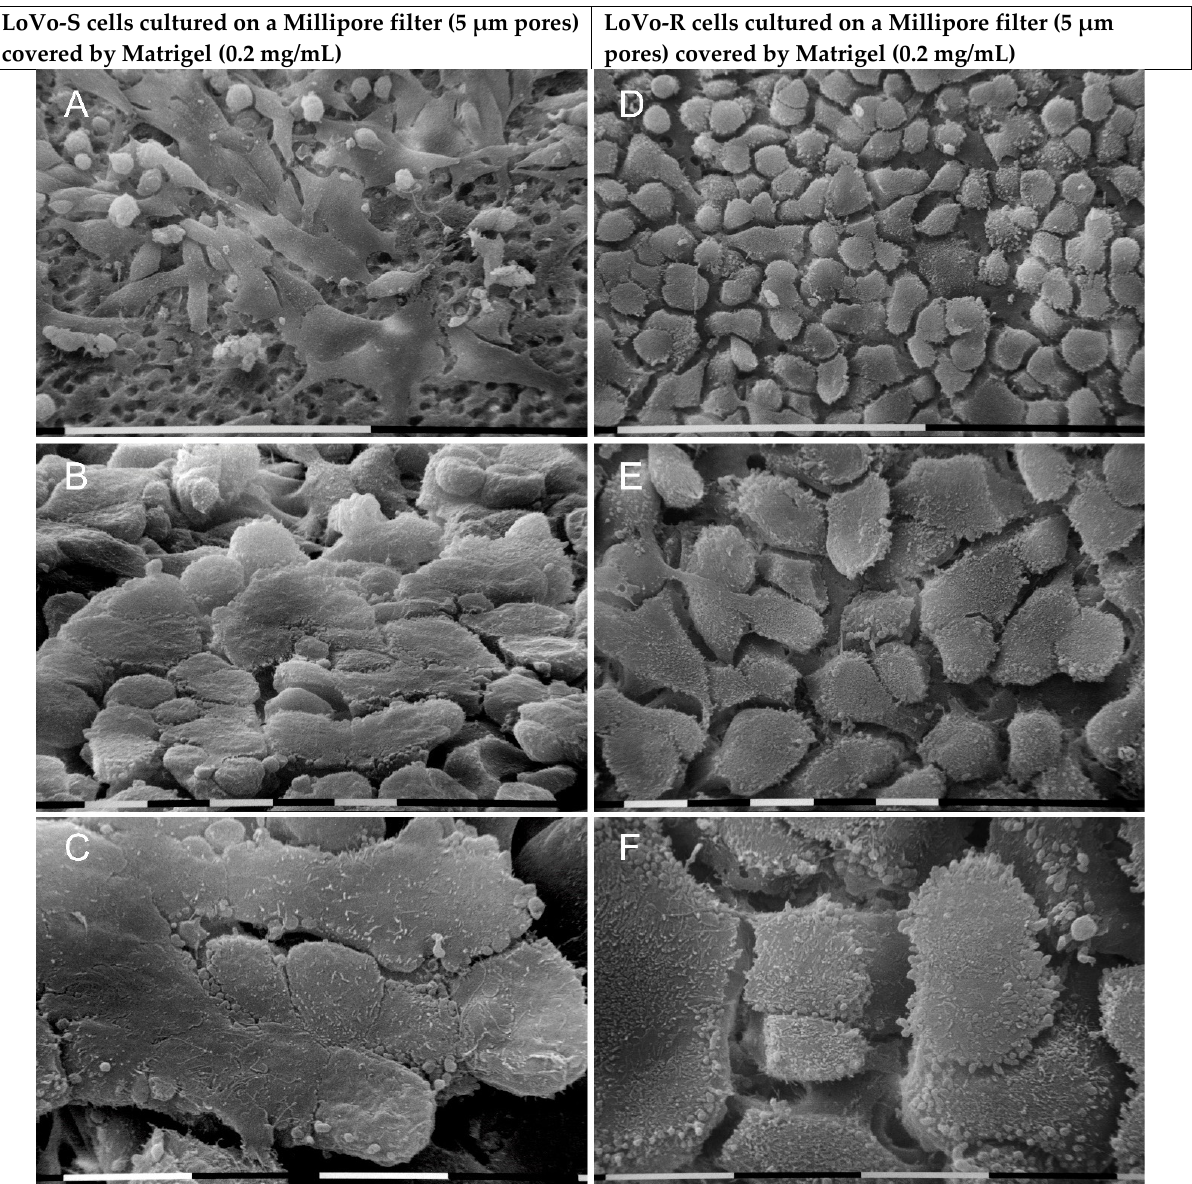
Figure 3. LoVo-S and LoVo-R were cultivated for 24 h on a Millipore filter with 5 µ m pores cov- ered by Matrigel at standard concentration mimicking the BM. LoVo-S cells show large and very flattened polygonal cells (10–20 µ m) in tight contact with each other, but also a few globular ones (10 µ m in diameter), which grow on the flattened ones ( A ). Sparse microvilli and a few vesicles are observable on their surface ( B , C ). Only a few ( ca 3%) of the polygonal cells developed a conic/funnel shape, which suggests they were trying to invade the Matrigel ( B ). All LoVo-R cells appear like grouped cobblestone-shaped cells (10–20 µ m) with a very flattened upper cytoplasmic surface and no tight contacts as an intercellular space wide 2–5 µ m are always visible. Densely distributed microvilli and microvesicles are evident on their cytoplasmic surface. ( D – F ). Bar = 100 µ m ( A , D ) Bar = 10 µ m ( B , C , E , F